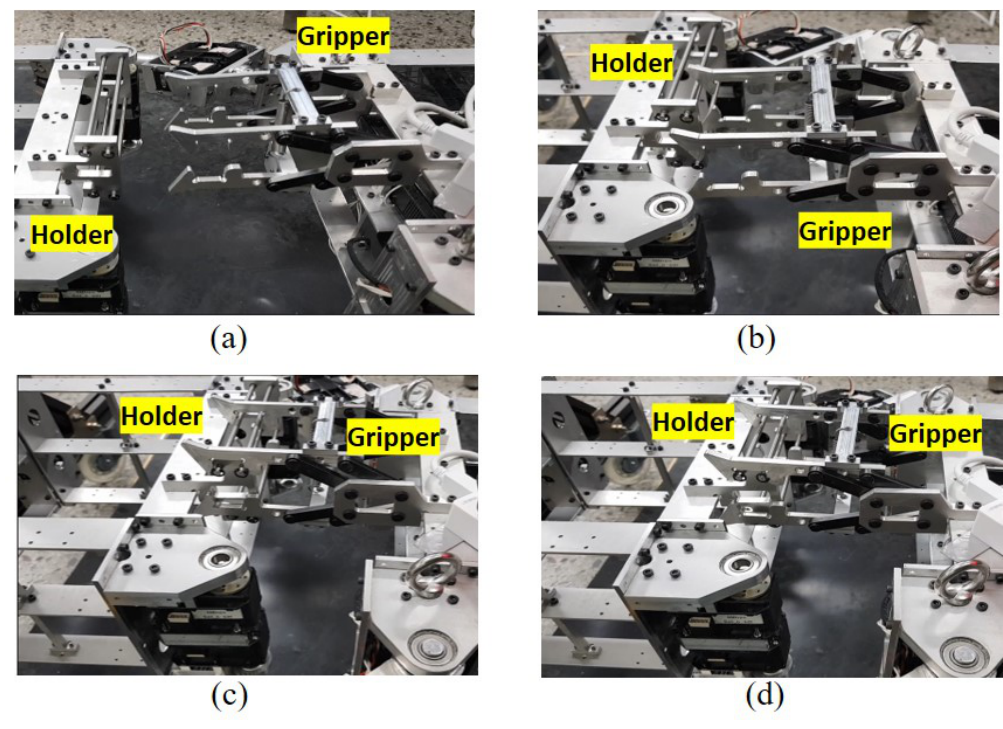
Figure 5. The coupling mechanisms are used in the combination process. ( a ) Ready to lock. ( b ) Contact with locking bar. ( c ) Semi-locked. ( d ) Fully